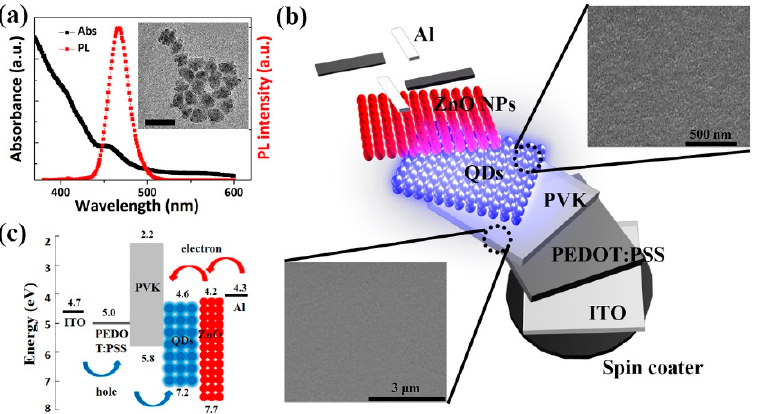
Figure 1. ( a ) Absorption and PL spectra of QDs. Inset is the TEM image of the synthesized QDs. Scale bar is 20 nm; ( b ) fabrication process of multilayered QLEDs. Insets are the SEM images of QDs layer (top) and PVK (bottom); ( c ) Energy level diagram for the various layers.